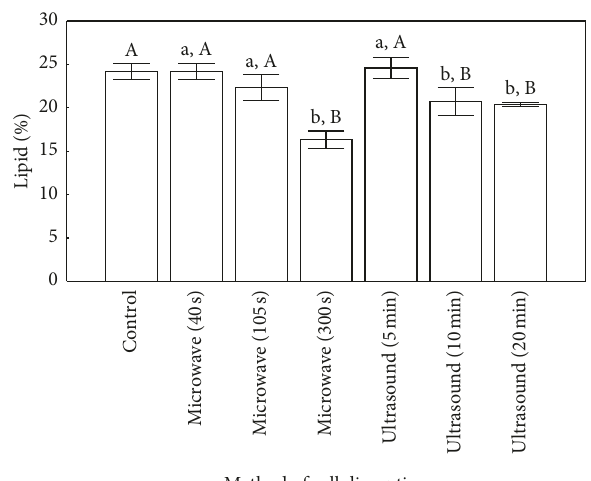
Figure 1: Lipid content of the microalga Chaetoceros calcitrans in different methods of cell disruption (mean values (bars) ± standard deviation (whiskers); n � 3). Equal small letters show that there was no significant difference ( p ≥ 0 . 05) between times of the same method of cell disruption. Equal capital letters show that there was no significant difference ( p ≥ 0 . 05) between methods of cell dis- ruption in comparison with the method of chemical